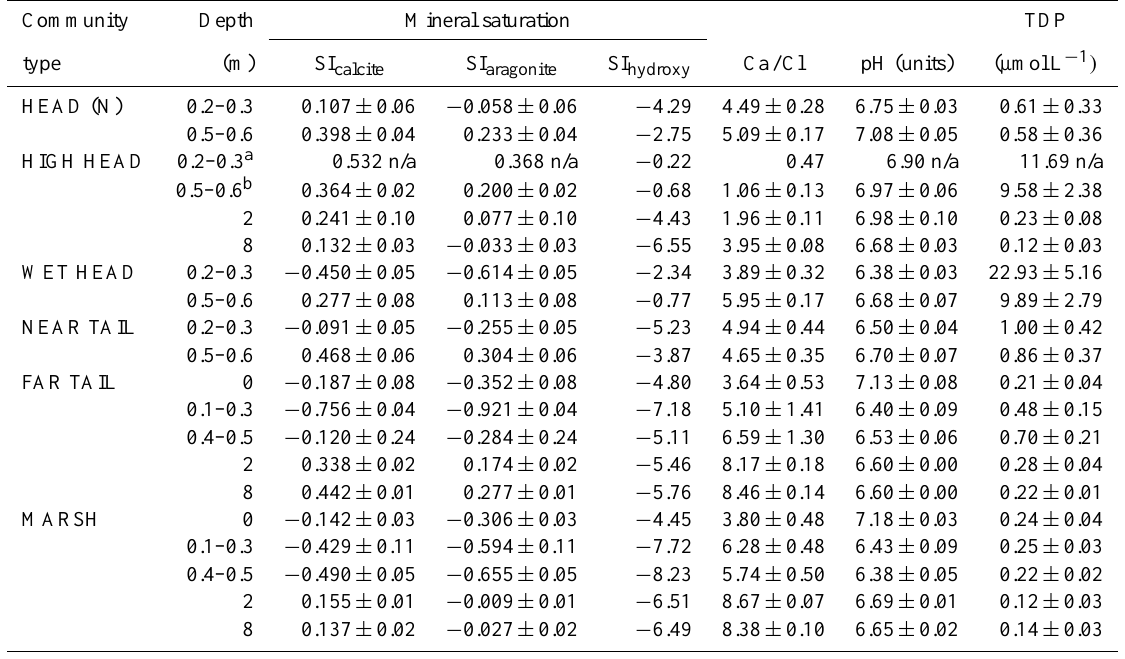
Fig. 5. Seasonal pattern of High Head water level (WL), precipitation deficit (Prec-ET), cumulative precipitation (Prec), lateral hydraulic gradient from High Head to Wet Head (Lat HG), and porewater recovery rate in the High Head (HH Mrc). See Table 1 for estimates of standard error where available. Table 2a. Calculated indices of mineral saturation, the ratio of Ca to Cl, pH and TDP in four tree island plant communities and adjacent deep-water slough averaged over the four sampling periods with standard error. For mineral saturation, supersaturated (SI>0 ± 0.10), ap- proximately saturated (SI ∼ 0 ± 0.10), and undersaturated (SI<0 ± 0.10) with respect to calcite, aragonite and hydroxyapatite as indicated. Average charge balance errors were <3% for most samples (see